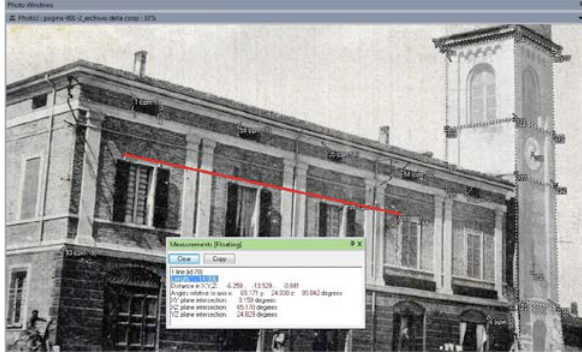
Figure 10. Extraction of one horizontal distance from the photogrammetric model.